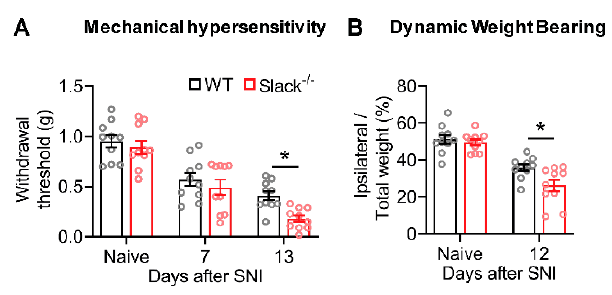
Figure 1. Neuropathic pain behavior is increased in Slack -/- mice. ( A ) paw withdrawal latencies of Slack -/- and wild-type (WT) mice after mechanical stimulation with von Frey filaments (up-and- down method) in the spared nerve injury (SNI) model of neuropathic pain ( n = 10 animals per group). Thirteen days after SNI, Slack -/- mice showed increased mechanical hypersensitivity compared to WT littermates (two-way ANOVA; p = 0.0312; WT versus Slack -/- ). ( B ) percentage of weight bearing on the ipsilateral hind paw relative to both hind paws in Slack -/- and WT mice ( n = 10 animals per group), as assessed using a dynamic weight-bearing device. Twelve days after SNI, the weight-bearing reduction was more pronounced in Slack -/- mice compared to WT littermates (two-way ANOVA; p = 0.0464; WT versus Slack -/- ) Bars denote mean ± SEM. * p <